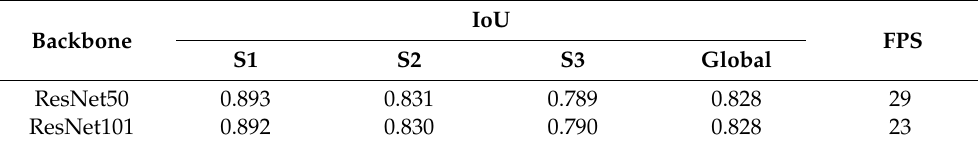
Table 3. Segmentation mask IoU for the different backbone